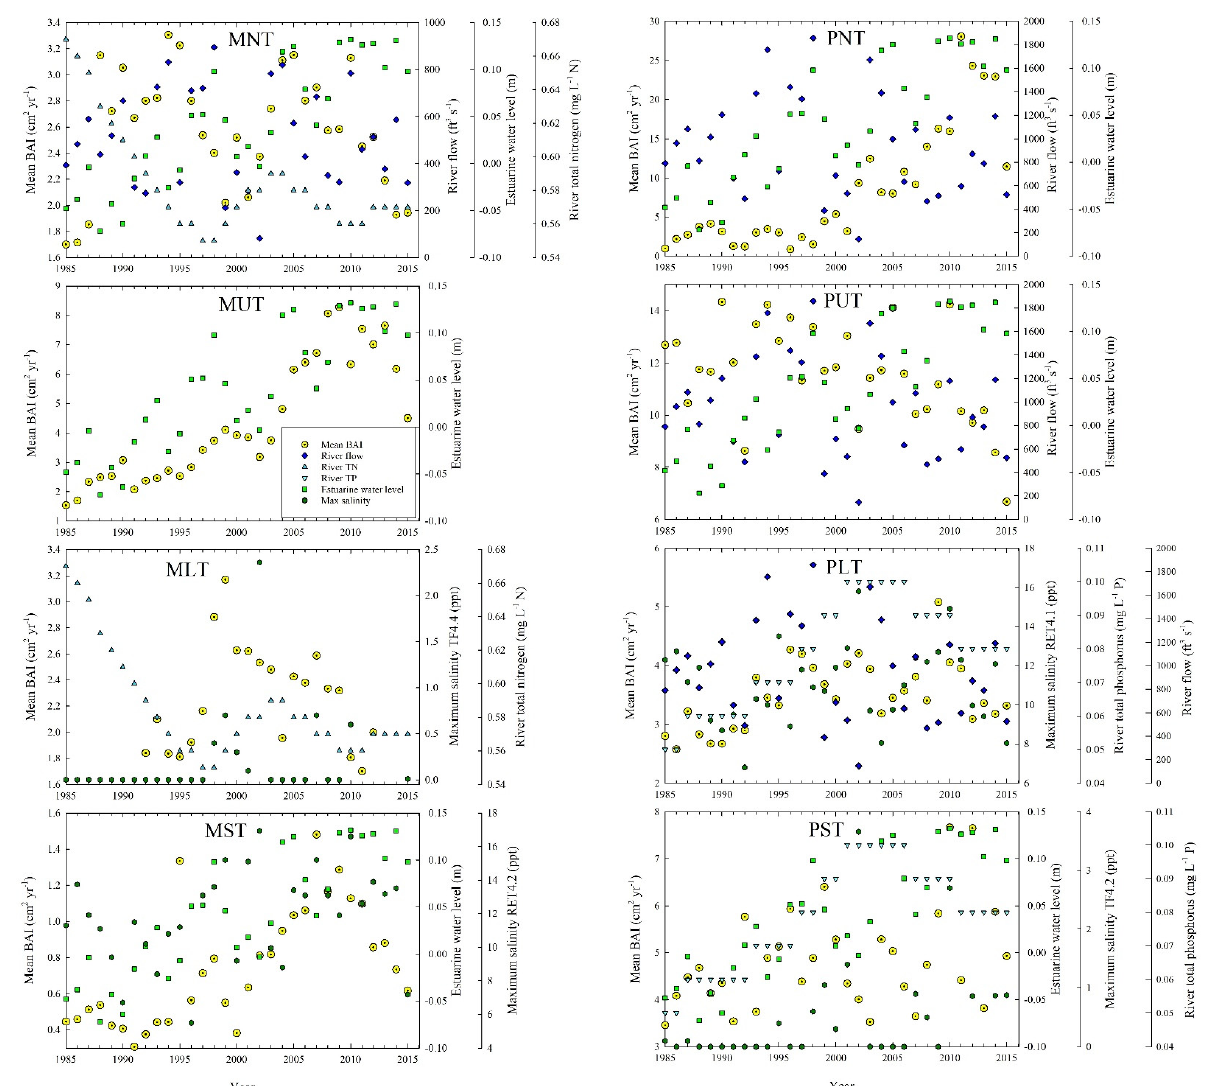
Figure 3. Changes in mean individual tree BAI and estuarine and watershed variables appearing in regression models of the Mattaponi River study sites ( left ) and Pamunkey River study sites ( right ). NT = nontidal, UT = upper tidal, LT = lower tidal, and ST = stressed tidal.